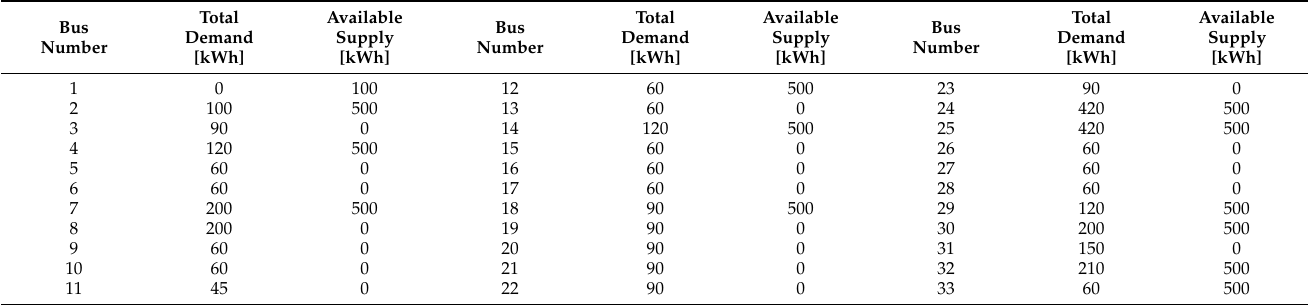
Table 2. Demand and Supply of Each Bus in the IEEE 33 Bus System